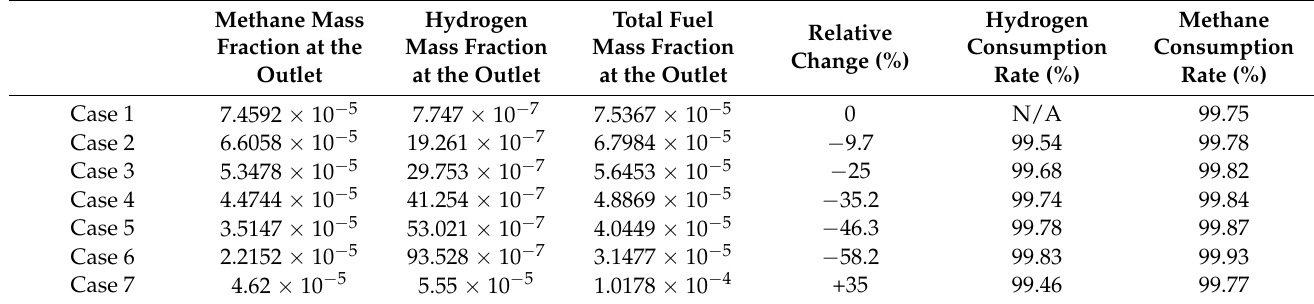
Table 3. The fuel residue at the combustor outlet under constant fuel mass flow rate.